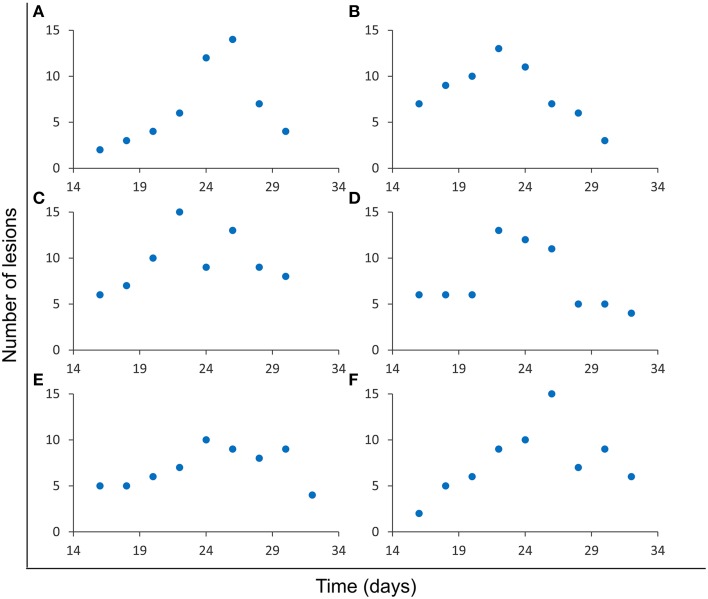
Evolution of the number of lesions in a single slide. Results from six independent simulations (A–F) obtained using the parameters for series A (Table 1). Different fluctuation patterns can be observed for this variable.